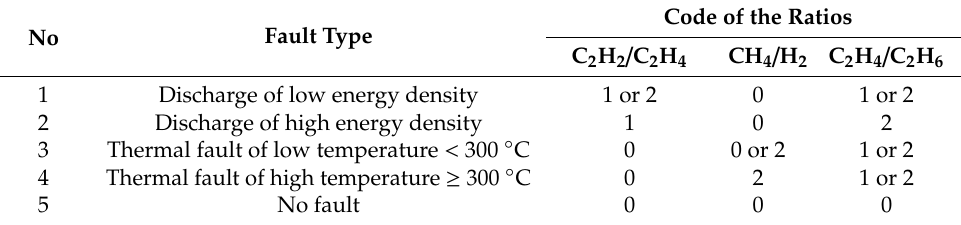
Table 4. Fault types of DGA